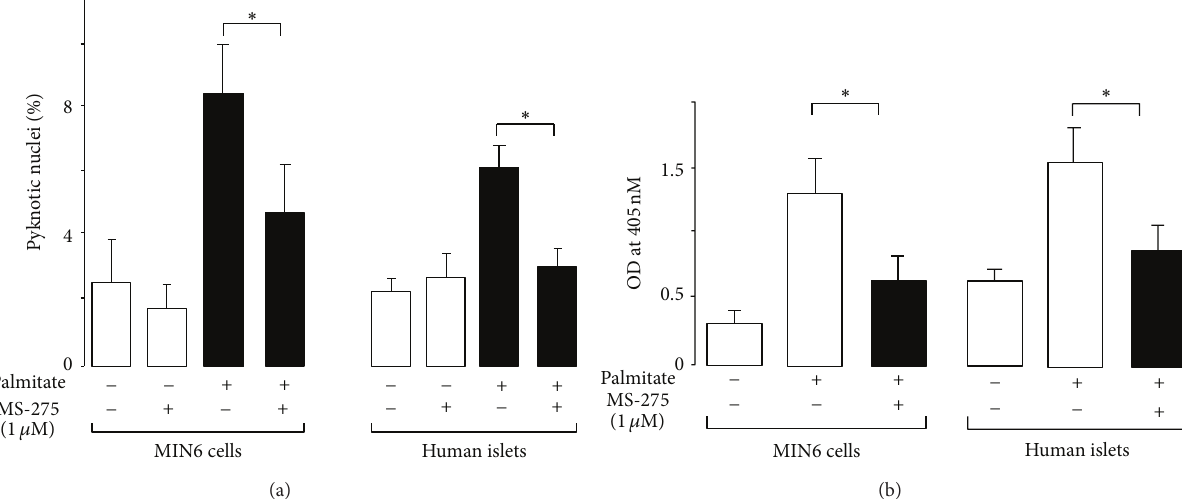
Figure 1: MS-275 alleviates apoptosis caused by palmitate in isolated human islets and MIN6 cells. Effect of MS-275 on (a) the number of pyknotic nuclei and (b) histone-associated DNA fragments. MIN6 or dispersed human islets cells were cultured with 0.5 mM palmitate (Palm, Sigma Aldrich, St. Louis, MO) or bovine serum albumin (BSA; − ) with 1 𝜇 M MS-275 (Sigma Aldrich, St. Louis, MO) or vehicle (DMSO; − ) for 48 hrs. The data are the mean ± SD of 4 independent experiments ( ∗ 𝑃 < 0.05